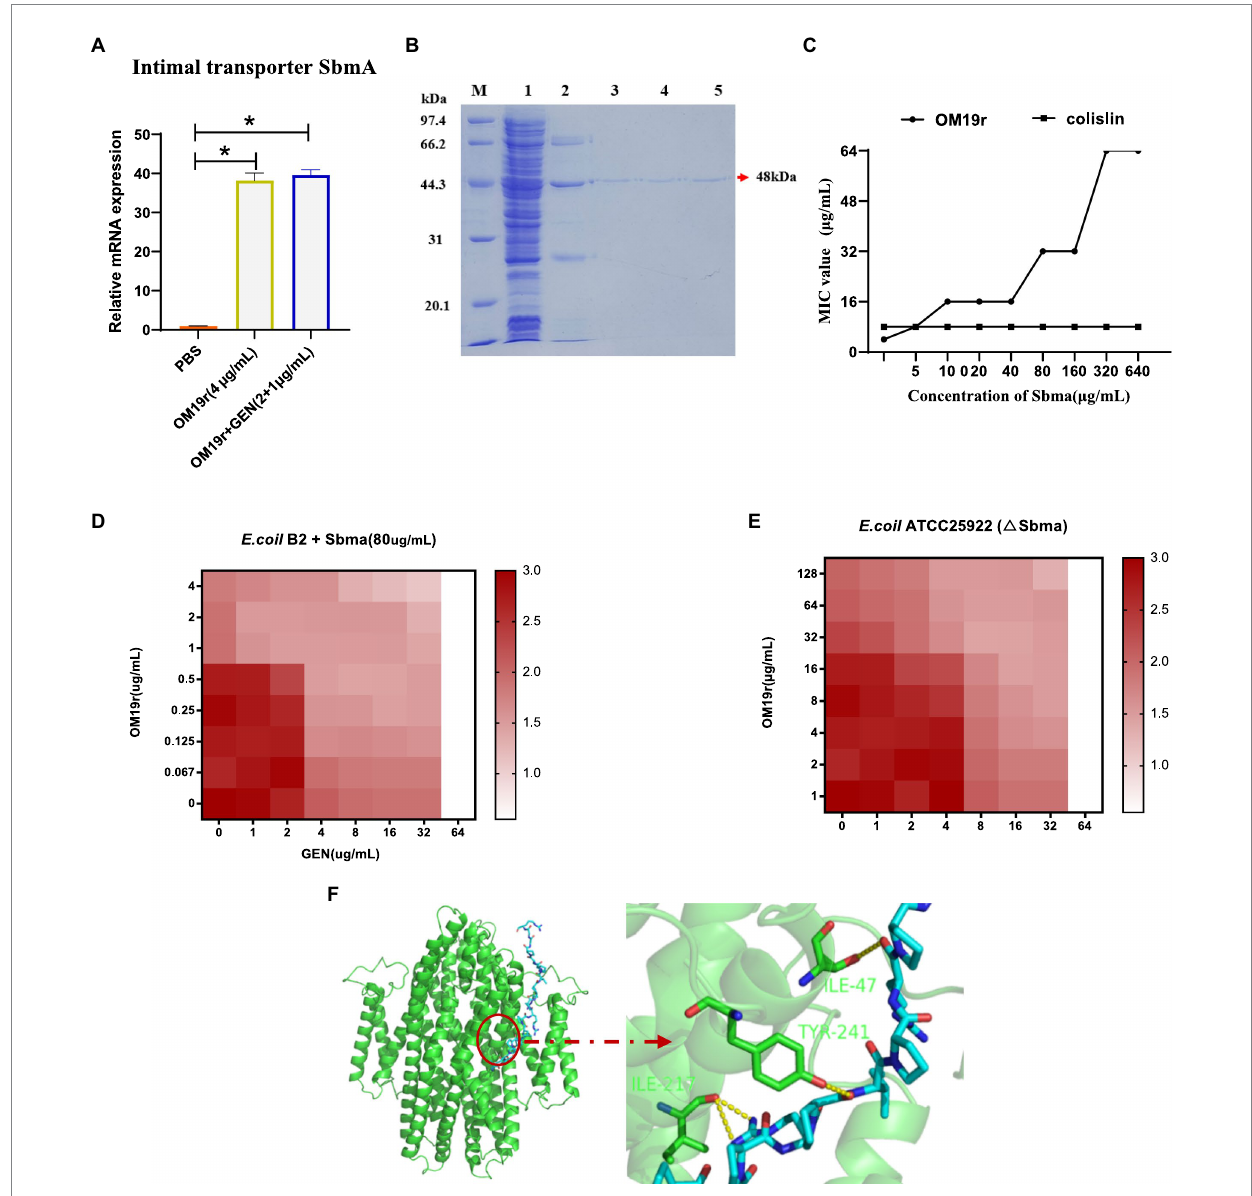
FIGURE 5 OM19r transported to cytoplasm by the SbmA protein on bacterial inner membrane. (A) The mRNA expression of SbmA gene increased after OM19r and OM19r combined with GEN against E. coli B2. (B) SDS-PAGE results of SbmA protein. M: Premixed Protein Marker(low), 1: flow through 2: 50 mM imidazole wash, 3: 100 mM imidazole wash, 4: 300 mM imidazole first wash, 5: 300 mM imidazole second wash. (C) Effect of SbmA on the antibacterial activity of OM19r and colistin against E. coli B2 was determined by adding SbmA protein in vitro . (D) Effect of SbmA on the FIC of OM19r combined with GEN against E. coli B2 was determined by adding SbmA protein in vitro . (E) FIC of OM19r combined with GEN against E.coli ATCC25922 ( △ SbmA) was determined in vitro . (F) Molecular docking results of both OM19r and SbmA protein